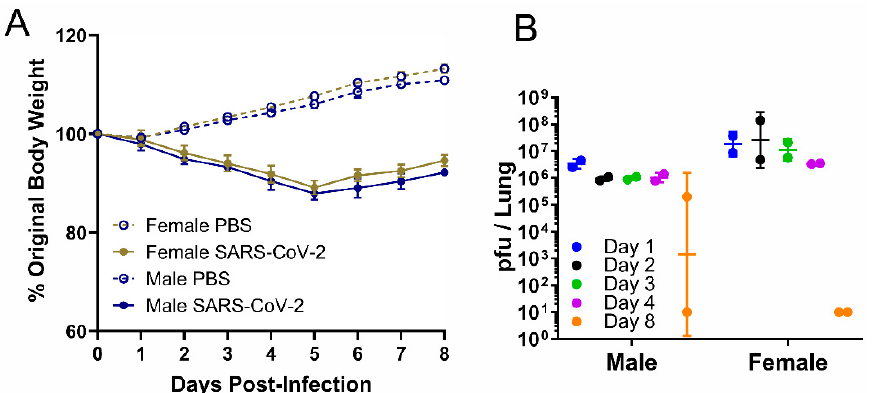
Figure 1. Weight and viral load in male or female hamsters intranasally infected with PBS or SARS- CoV-2 at a high dose, 2 × 10 5 pfu. In the serial sacrifice study of SARS-CoV-2-infected hamsters, ( A ) body weight change (data are presented as mean ± SEM) was measured daily from 0 to 8 dpi, and ( B ) viral load was measured by plaque assay in lungs of male and female hamsters at five time points ( n = 2). Data are presented as geometric mean ± geometric